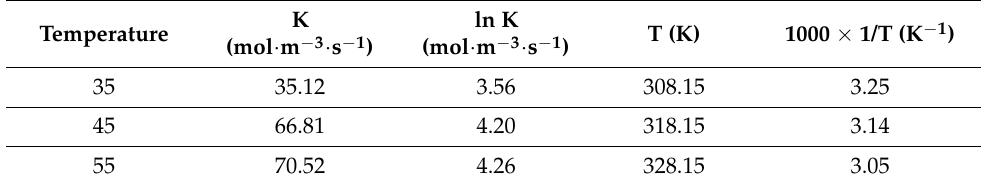
Figure 6. Fitting diagram of the second-order reaction at different temperatures. The slope (K value) of the above fitting line and the different temperatures (T value) were listed in Table 7 below. Table 7. The variables of the Arrhenius equation.